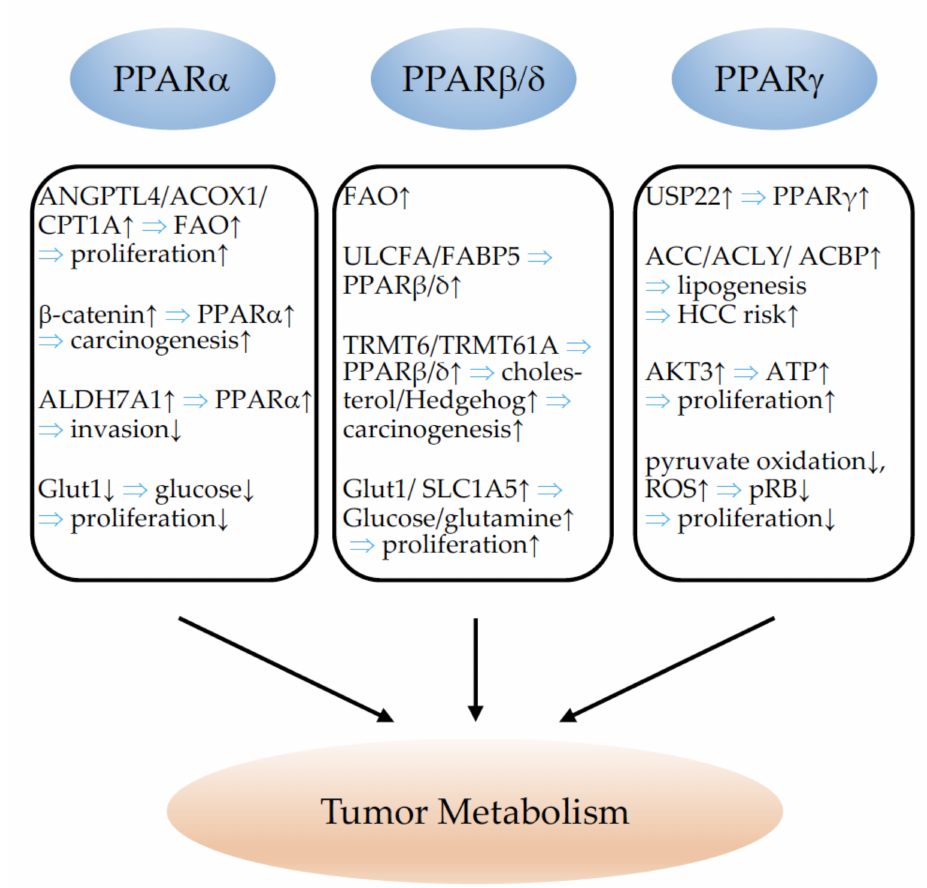
Figure 7. Summary of the effects of PPAR α , PPAR β / δ , and PPAR γ on tumor metabolism. ↓ indi- cates inhibition and ↑ indicates an increase. ⇒ : leads to; ANGPTL4: angiopoietin-like 4; ACOX1: acyl-coenzyme A oxidase 1; CPT1A: carnitine palmitoyltransferase 1A; FAO: fatty-acid oxidation; ALDH7A1: aldehyde dehydrogenase 7 family member A1; Glut1: glucose transporter 1; ULCFA: unsaturated long-chain fatty acids; FABP5: fatty-acid-binding protein 5; TRMT6: tRNA methyl- transferase 6 non-catalytic subunit; TRMT61A: tRNA methyltransferase 61A; SLC1A5: solute carrier family 1 member 5; USP22: ubiquitin-specific peptidase 22; ACC: acetyl-CoA carboxylase; ACLY: ATP citrate lyase; ACBP: acyl-CoA binding protein; HCC: hepatocellular carcinoma; AKT3: AKT serine/threonine kinase 3; ATP: adenosine triphosphate; ROS: reactive oxygen species; pRB: phos- phorylated retinoblastoma